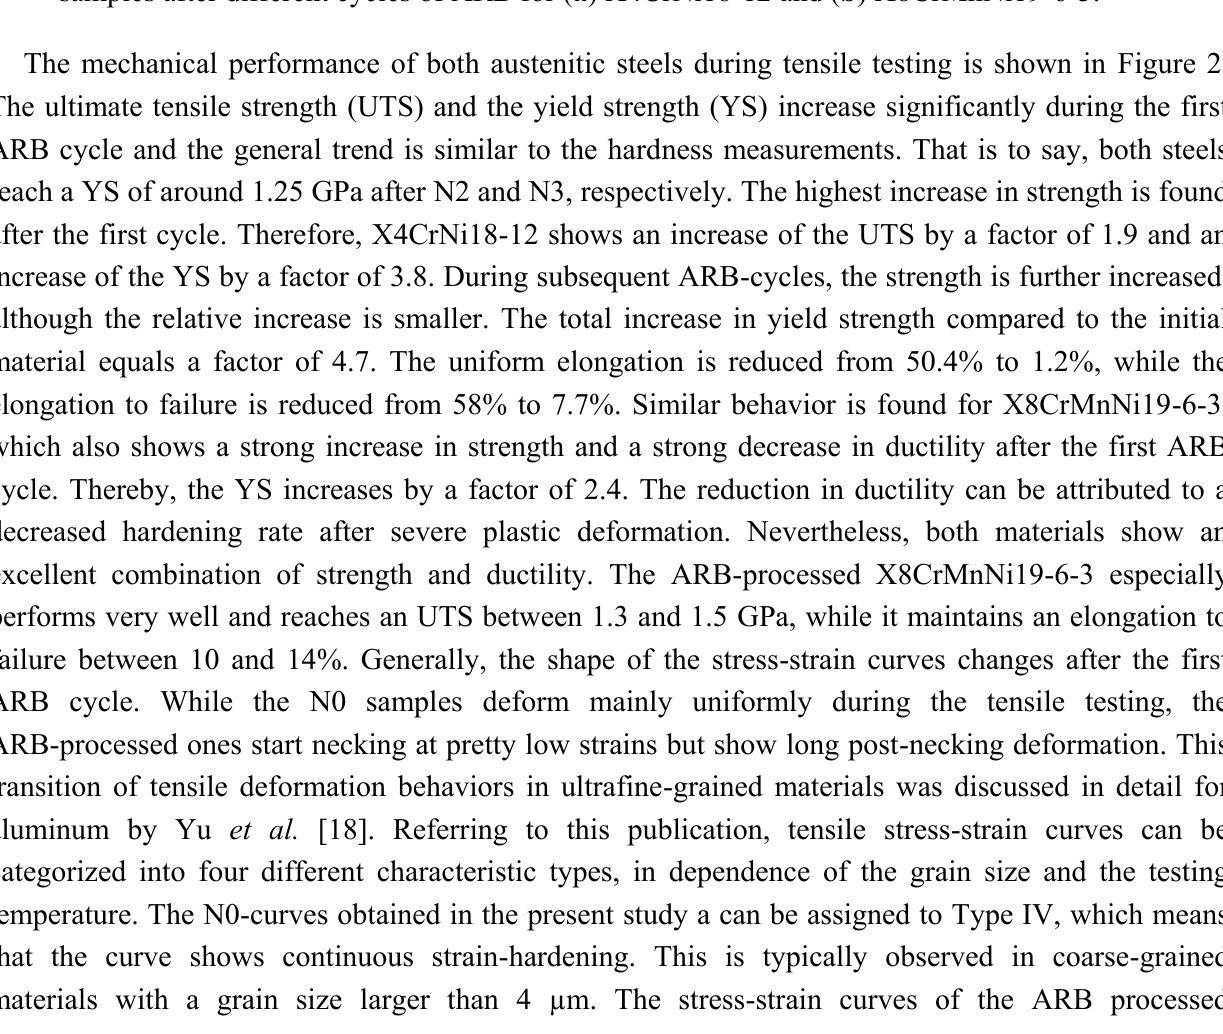
Figure 1. Vickers hardness measurements at the sheet, rolling and transversal planes of the samples after different cycles of ARB for ( a ) X4CrNi18-12 and ( b )